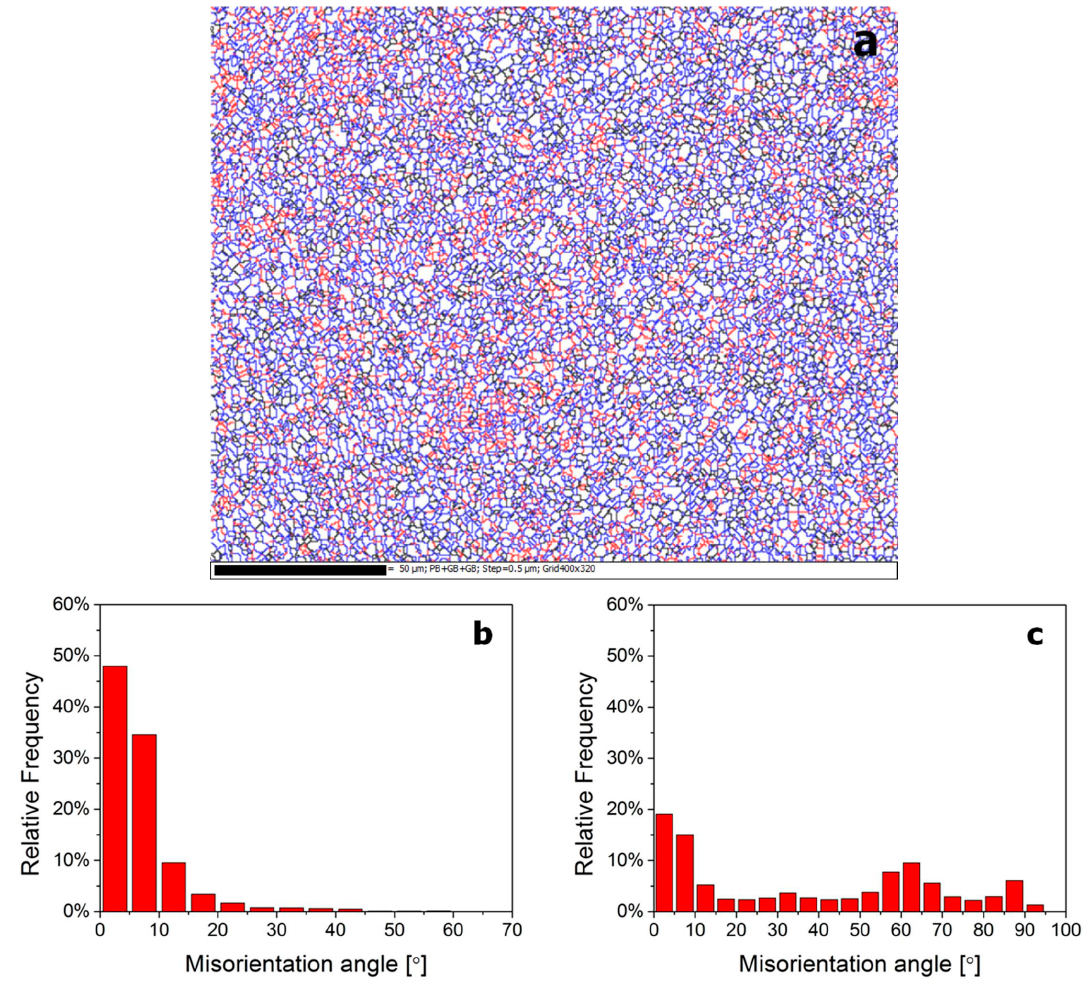
Figure 9. EBSD grain boundary map ( a ) and corresponding misorientation distributions of the annealed β 20C alloy in β ( b ) and α ( c ) phases.